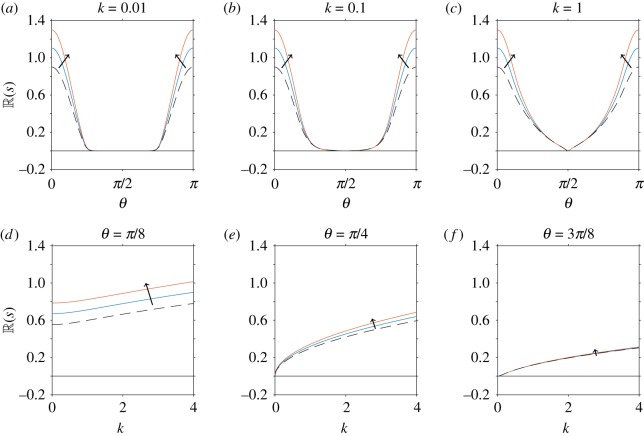
Linear stability analysis of a nearly aligned suspension, for variations in volume fraction (ϕ), when mechanically anisotropic effects are included but translational diffusivity is neglected. The real part of the growth rate (R(s)) for changes in the volume fraction ϕ = 0, 0.1, 0.2, where the arrow indicates the direction of increase. The Péclet number, shape parameter and stresslet strength are constant (1/P¯e=0, α0 = 0.8 (equivalent to Γ = 3), α1 = − 1). The dependence of R(s) on the wave-direction θ is shown for fixed values of the wavenumber (a) k = 0.01, (b) k = 0.1, (c) k = 1, and the dependence of R(s) on k for fixed values of (d) θ = π/8, (e) θ = π/4, (f) θ = 3π/8. The dashed line represents the case ϕ = 0, i.e. the regime considered by Saintillan & Shelley [32]. The black solid line in all plots indicates R(s)=0, i.e. the boundary between instability and stability.